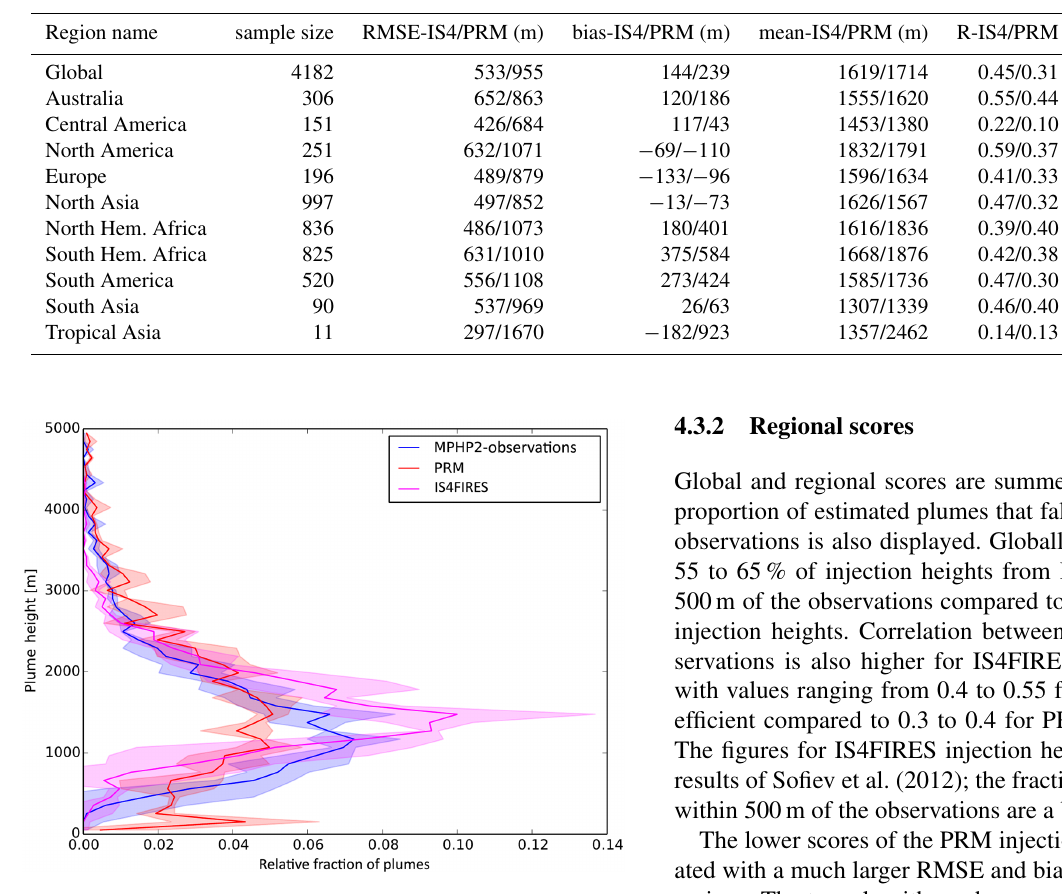
Figure 6. Global distribution of injection height from IS4FIRES and mean height of maximum injection from the PRM (for fires with MPHP2 observations),and of MPHP2 observations for 2008. Shading represents uncertainties of 200m in the plume height ob- servations and parameterisations. The sum over the vertical of the relative fractions is 1 for all